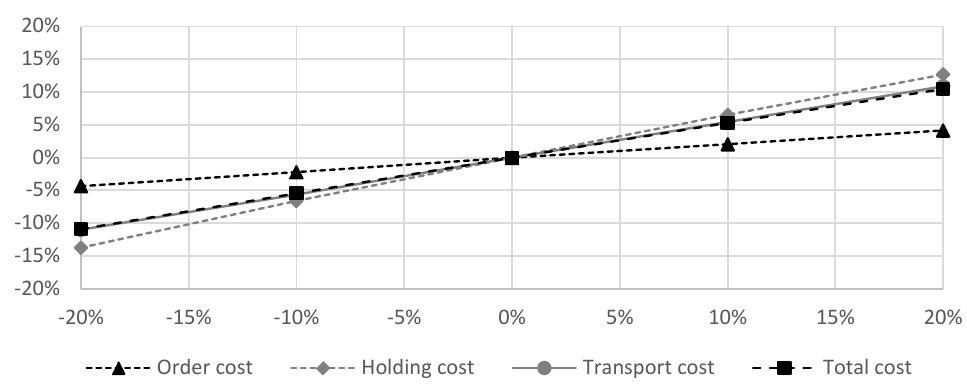
Figure 5. Changes in total logistics cost, transport cost, order cost and holding cost (in percent) as a function of change in total transport